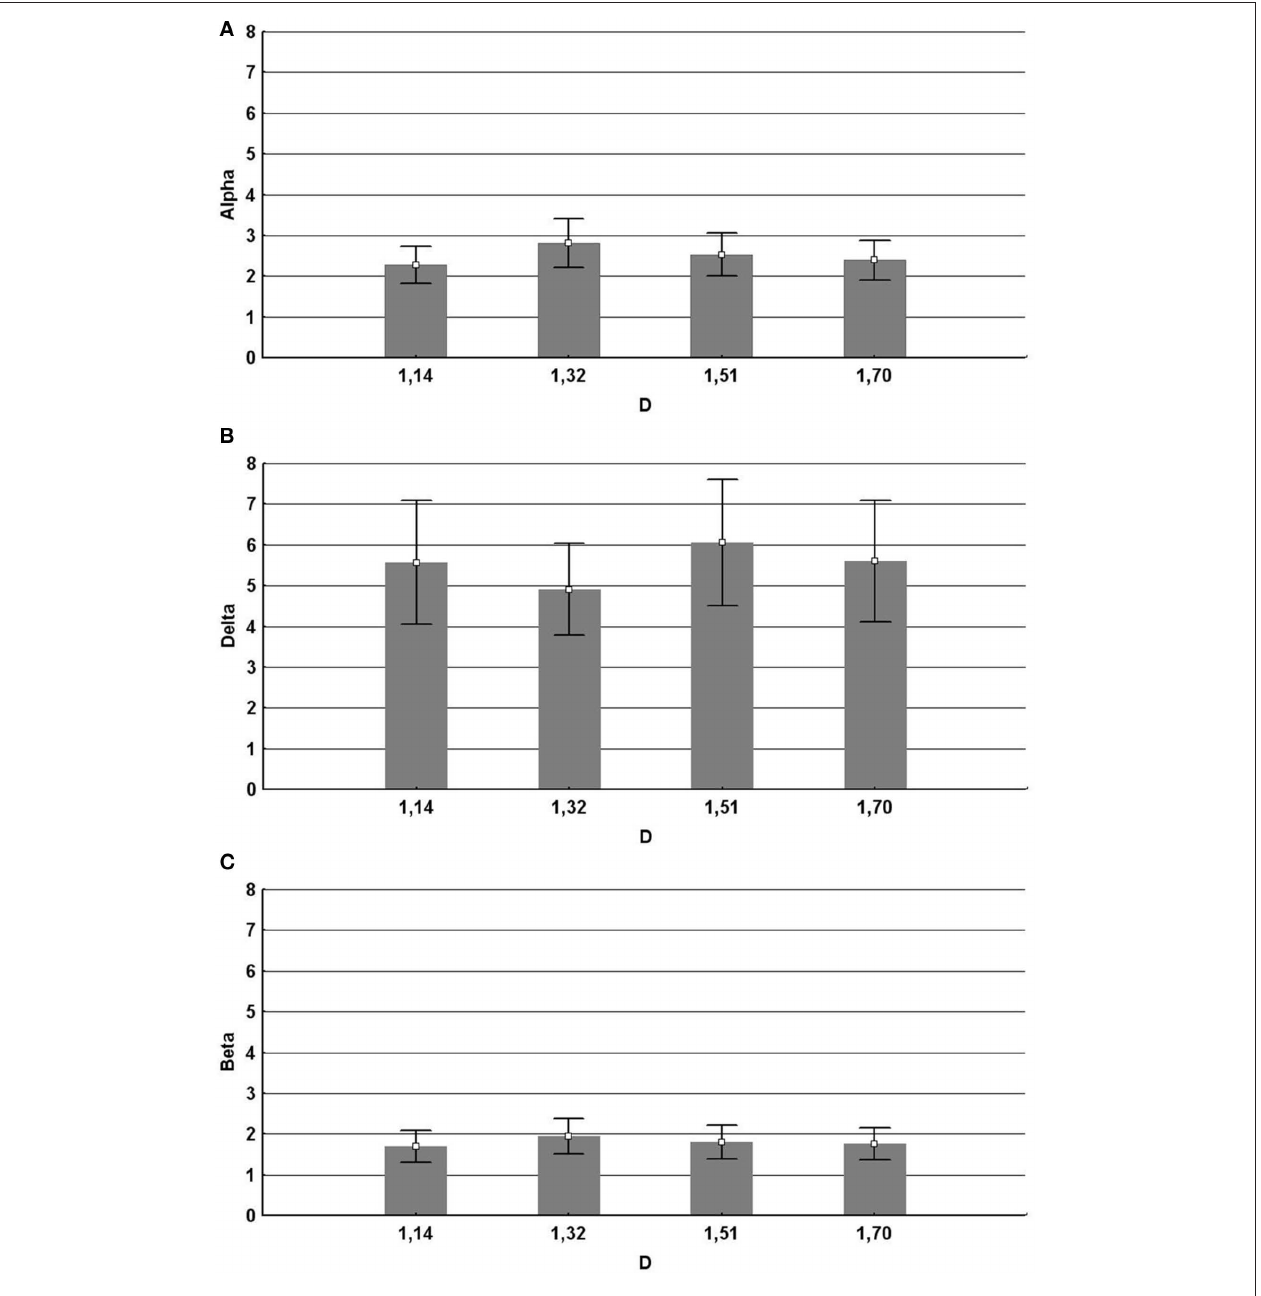
frontal regions F3F4 together for D = 1.14 (5.57 ± 5.96), D = 1.32 (4.91 ± 4.44), D = 1.51 (6.06 ± 6.11), and D = 1.70 (5.60 ± 5.86). (C) Beta for the parietal regions P3P4 together for D = 1.14 (1.69 ± 1.57), D = 1.32 (1.95 ± 1.74), D = 1.51 (1.80 ± 1.63) and D = 1.70 (1.76